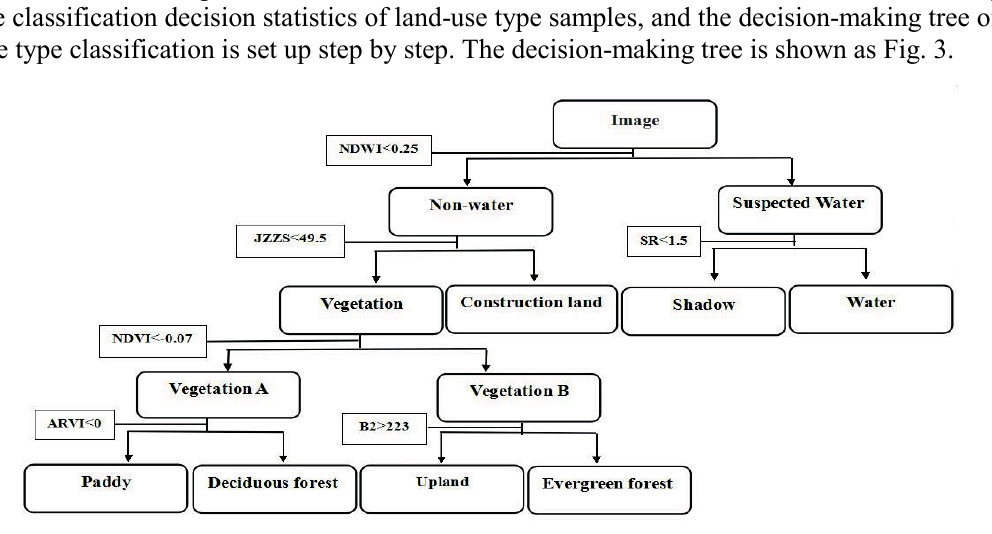
Fig. 3 Decision-making tree of land use type classification (left branch represents